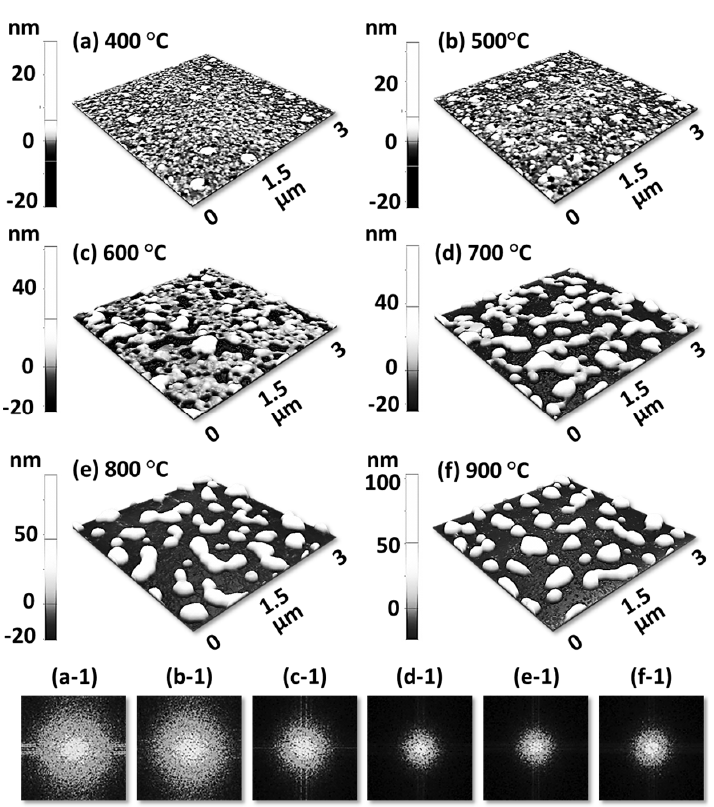
Figure A3. Evolution of dome-shaped AuAgPd alloy NPs from deposited tri-layers of 15 nm total thickness with 2 nm of of Au, Ag, and Pd layers. The fabrication was performed between 400 and 900 °C for constant 450 s. ( a – f ) AFM 3D side-views of 3 × 3 µm 2 . ( a - 1 – f - 1 ) Corresponding FFT power spectra. The circular pattern of FFT spectra gradually reduced with the evolution of alloy NPs denoting the improved overall surface height distribution.